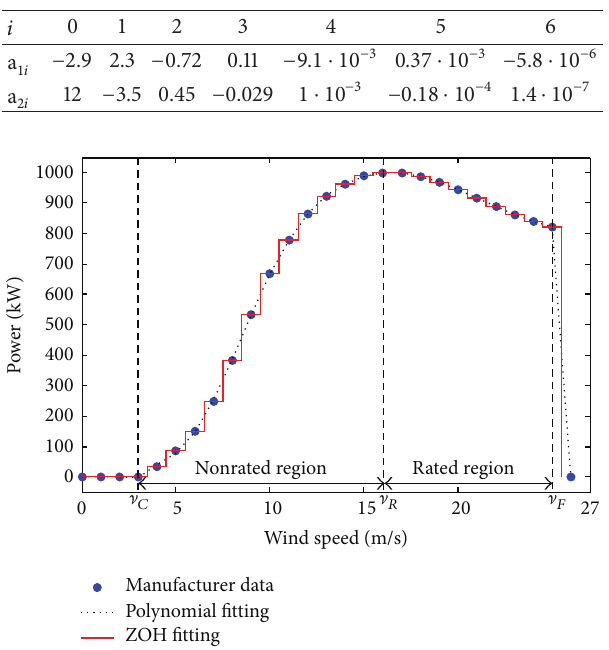
Table 3: 6th-order fitting coefficients of NEG Micon 1000/60 power curve.